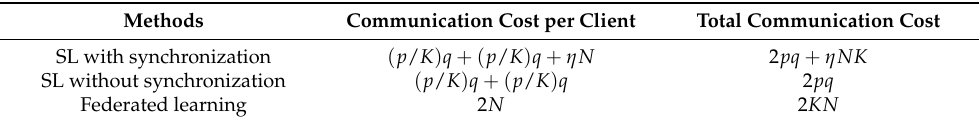
Table 3. SL and FL communication overheads per client and entire